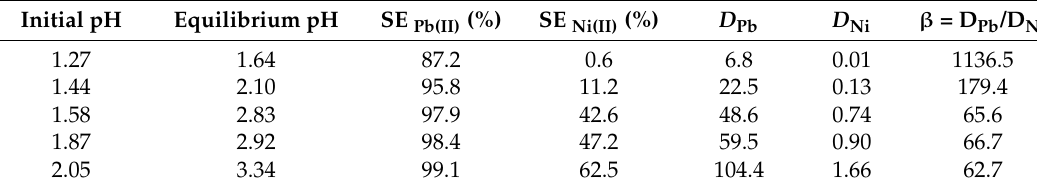
Table 1. Selectivity of Pb(II) and Ni(II) using CAM-D2EHPA material as sorbent.